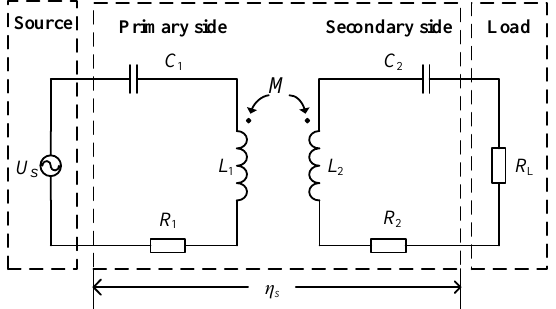
Figure 1. Equivalent circuit of Magnetic Coupling Resonant Wireless Power Transfer (MRC-WPT) system.